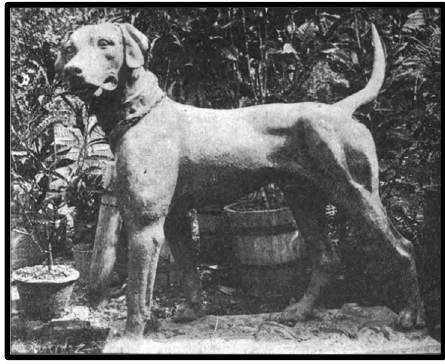
Figure 2. Ingalls’ Dog Statue [25].